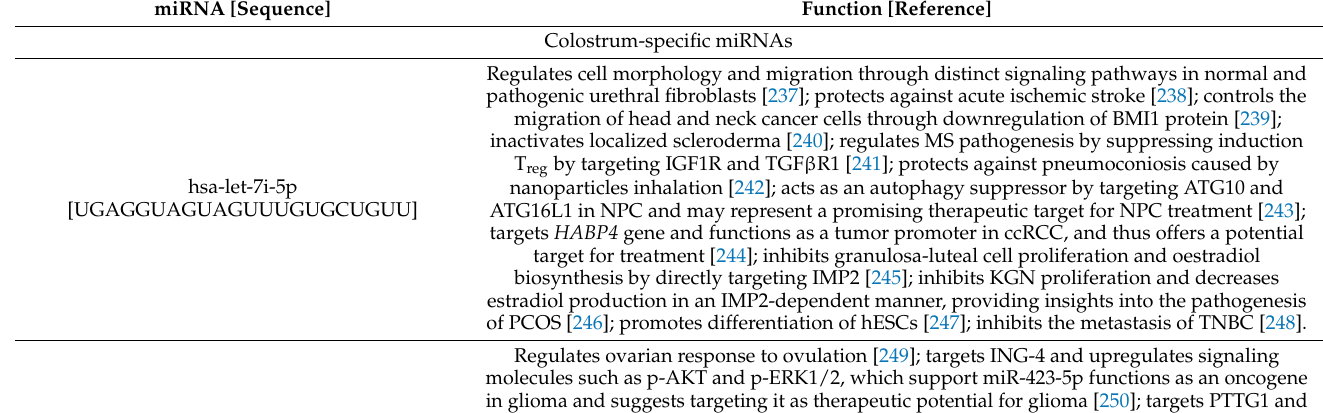
Table 3. The abundantly expressed miRNAs in HBM and their physiological functions in normal and pathological